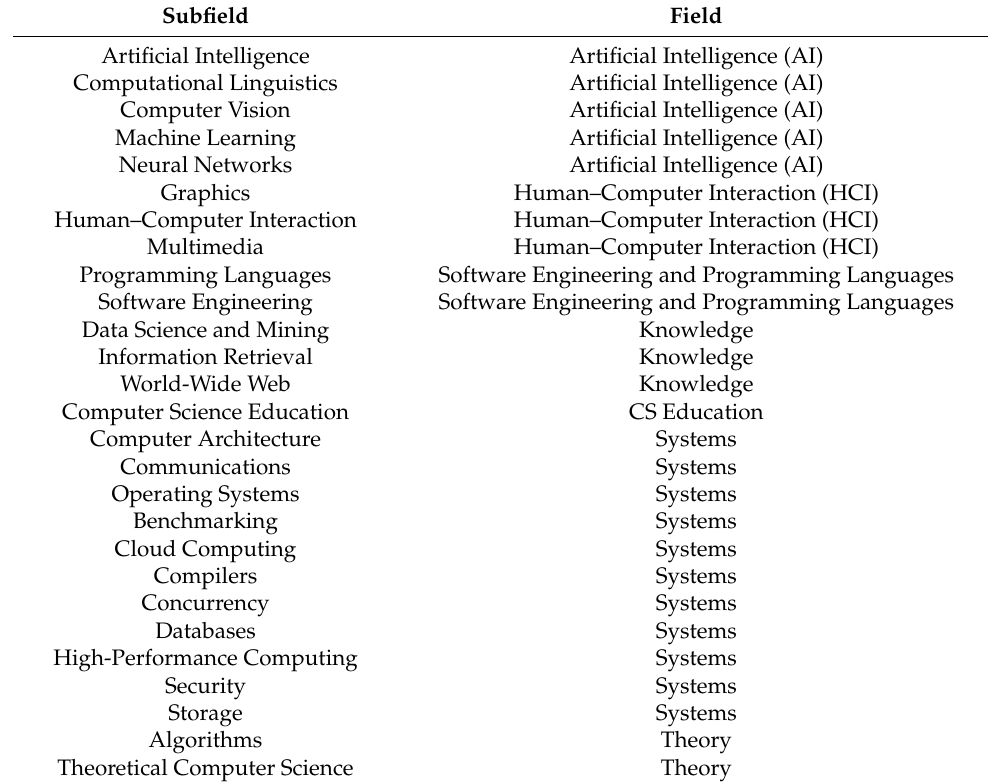
Table 2. All CS subfields analyzed, arranged by